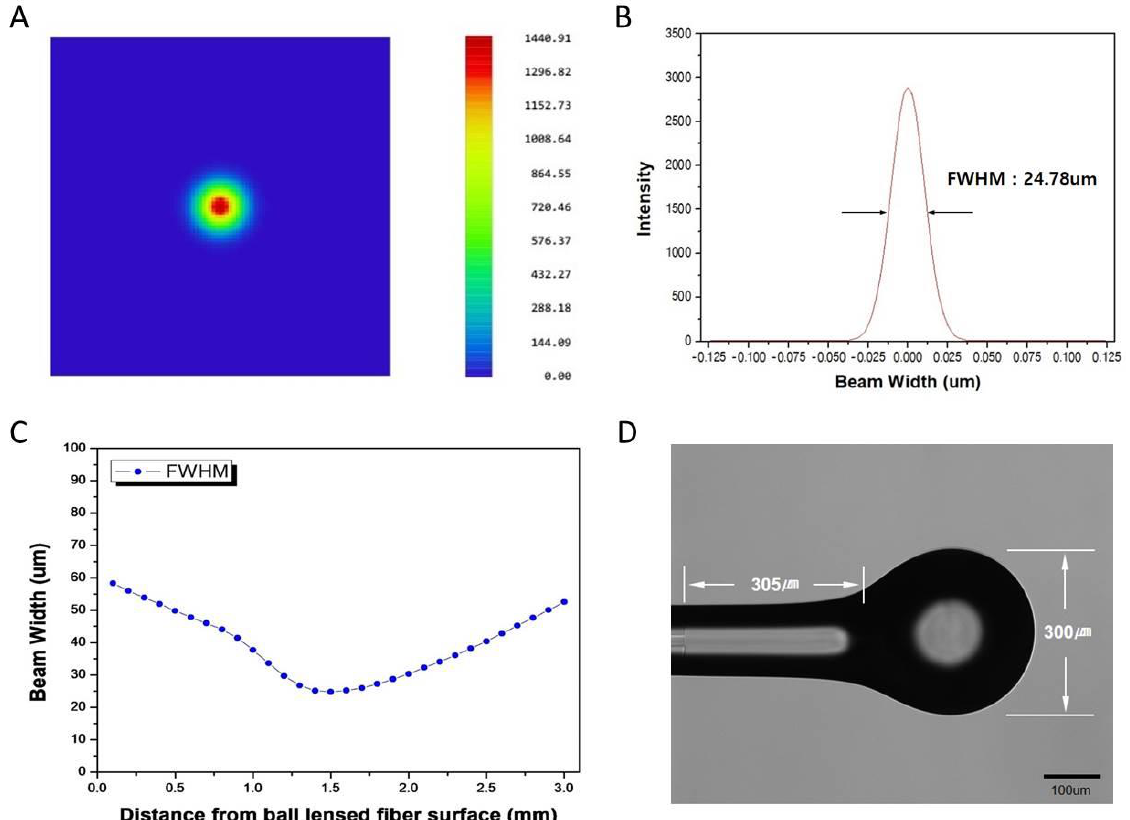
Figure 4. Information on the ball-lensed optical fiber (BLOF). ( A ) Intensity profile of a beam at the focal plane ( z = 1.5 mm). ( B ) Intensity line profile along the horizontal arrow. ( C ) Beam widths according to the distances of the laser beam emitted from the BLOF. ( D ) Manufactured BLOF using a fusion splicing machine.